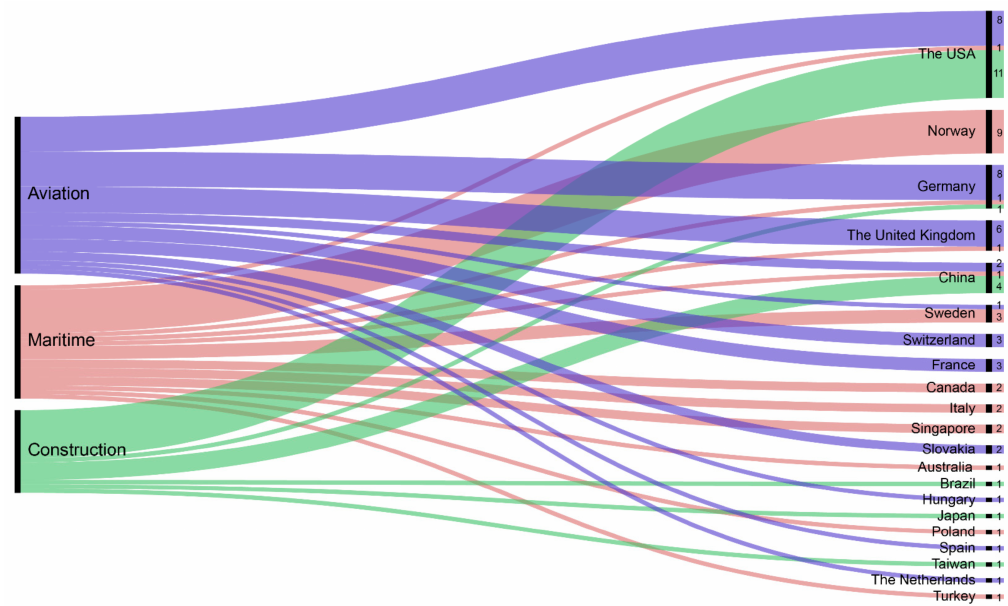
Figure 5. Distribution of identified studies according to industry and number of articles per region (created with RAW- Graphs